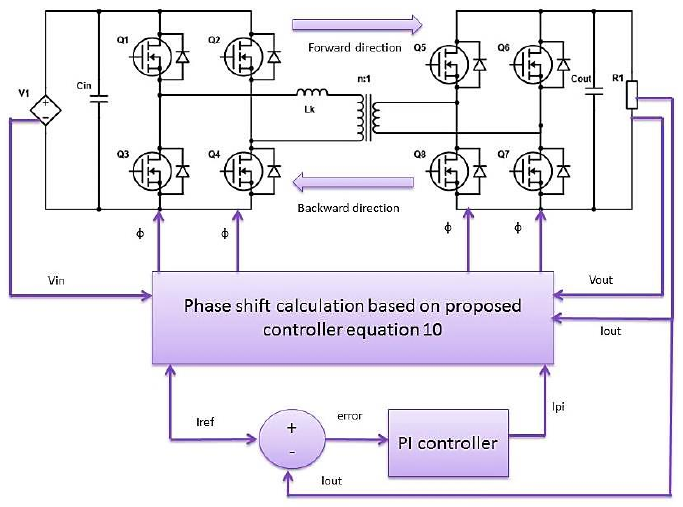
Figure 6. Block representation of proposed fast current controller for SPS DAB–DC/DC converter.